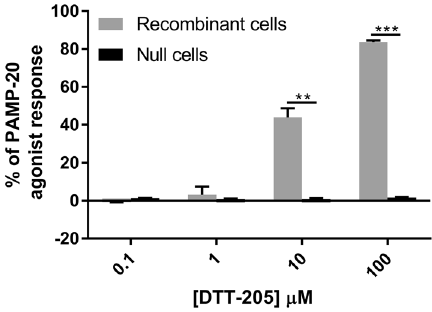
Figure 6. Calcium flux after treatment with DTT-205. Release of calcium flux, shown as % of calcium flux induced by PAMP-20 agonist in recombinant and null cells after treatment with increasing doses of DTT-205. Error bars indicate standard deviation. **p < 0.01, ***p < 0.001.